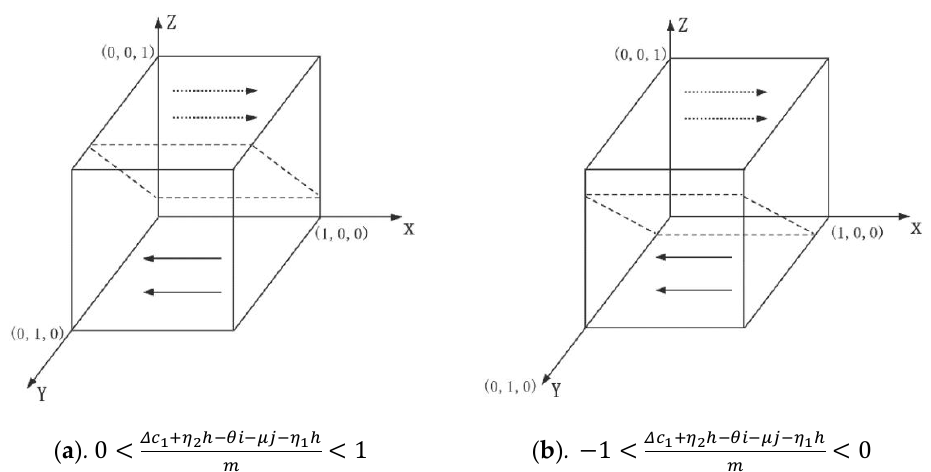
Figure 2. Evolution phase diagram of central government strategy selection under different condi- tions.